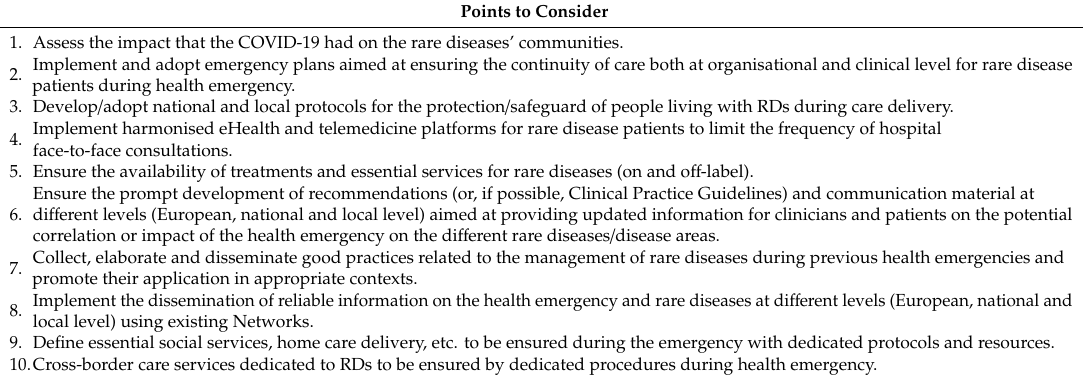
Table 1. Organisational points to consider in order to ensure appropriate care to RDs in case of new health